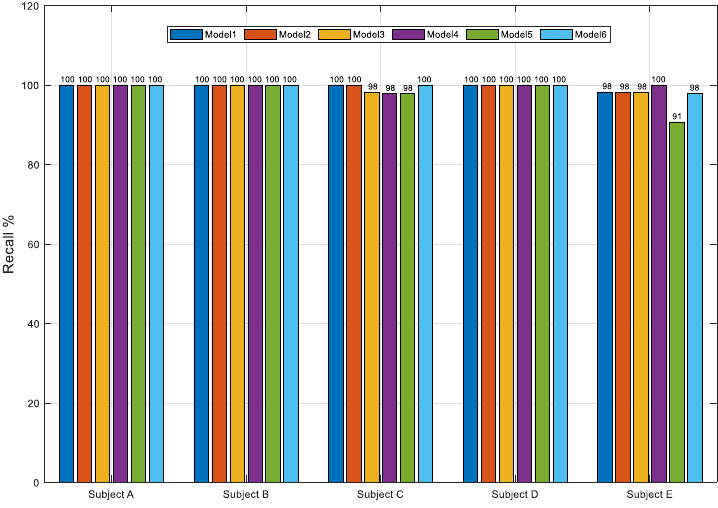
Figure 5. Average classification recall percentages over five subjects with six models.